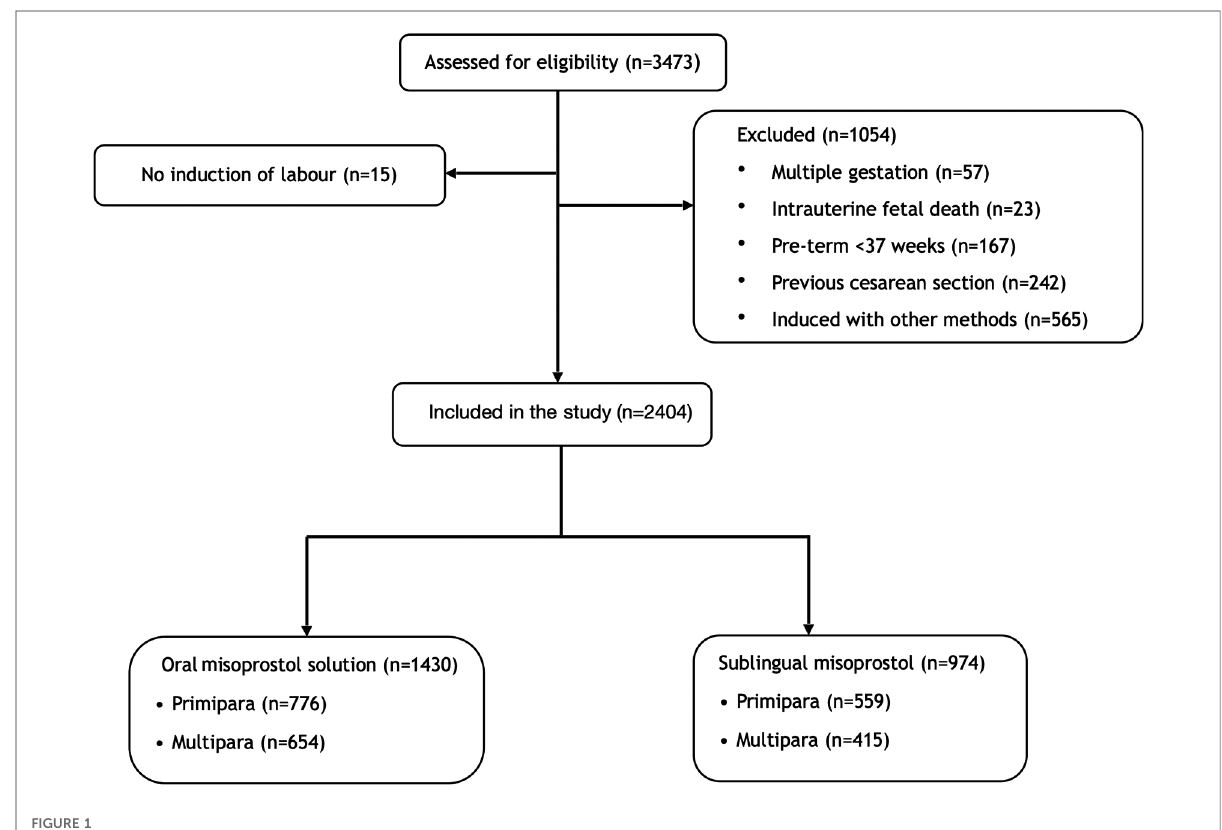
FIGURE 1 Flow chart of the included